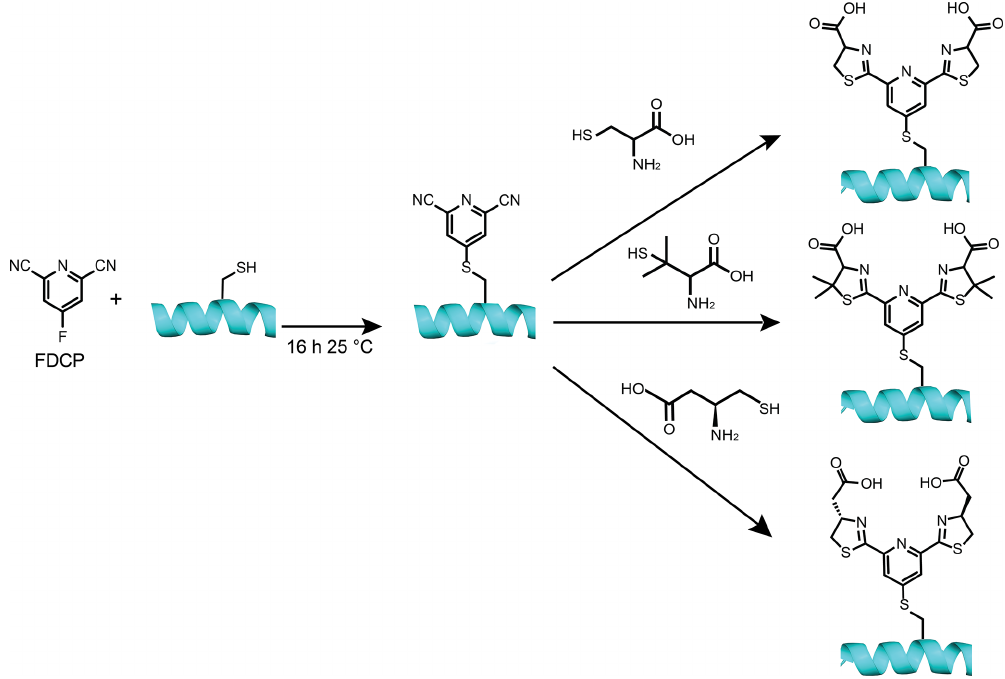
Figure 1. Construction of lanthanoid binding motifs on a protein using FDCP. Initially, a solvent-exposed cysteine or selenocysteine residue on the protein is reacted with FDCP. Typical reaction conditions involve incubating the protein at a concentration of 50µM with 250µM FDCP at 25 ◦ C and pH7.5 for 16h (10min for selenocysteine) to install the DCP tag on the protein. Prior to the tagging reaction, the reduced state of the cysteine thiol group was ensured by treating the protein with 10mM DTT for 0.5h followed by extensive buffer exchange to remove DTT. A second step assembles the final lanthanoid binding motif by reacting the FDCP-tagged protein for 0.5h at 25 ◦ C and pH7.5 in the presence of 10mM TCEP with either (top) 0.5M L - or D -cysteine, (middle) 0.5M L - or D -penicillamine, or (bottom) 0.5M ( S )-3-amino-4-mercaptobutanoic acid ( β